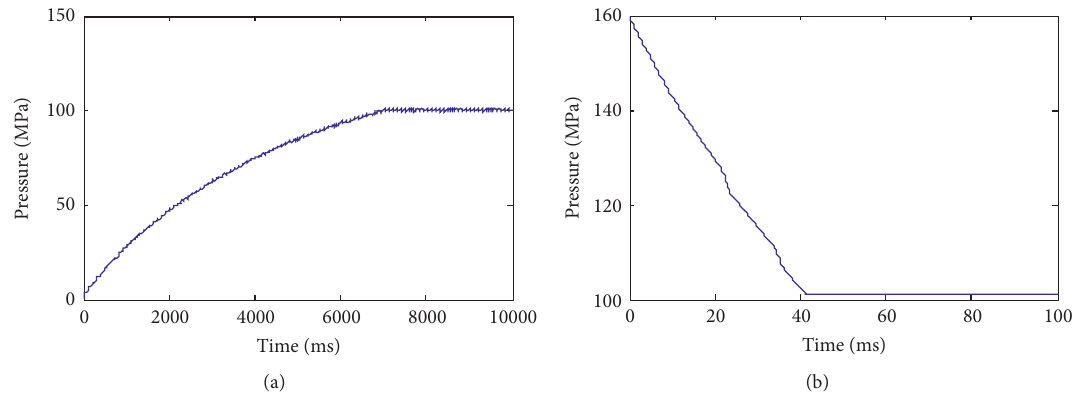
Figure 12: Schematic of fuel pressure recovery from low or high level to normal